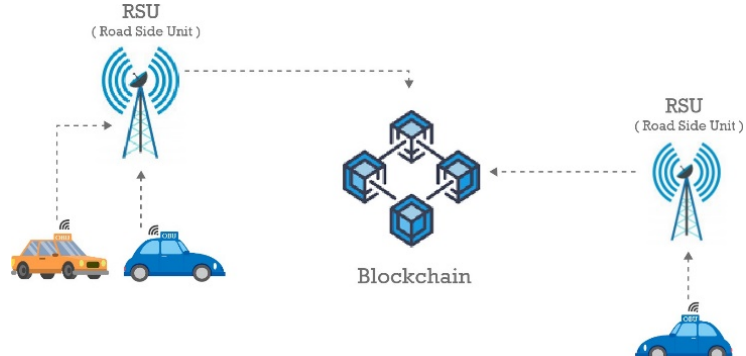
Figure 7. Blockchain in vehicular ad hoc networks (VANETs) [91].